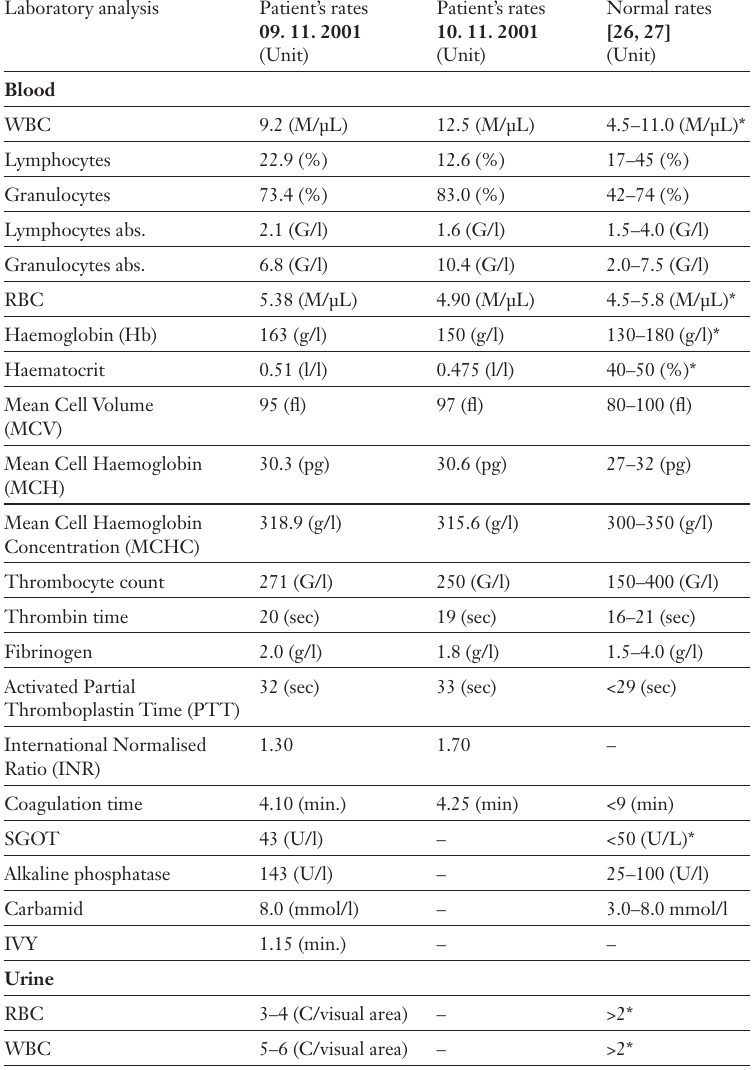
laboratory findings (*normal rates in